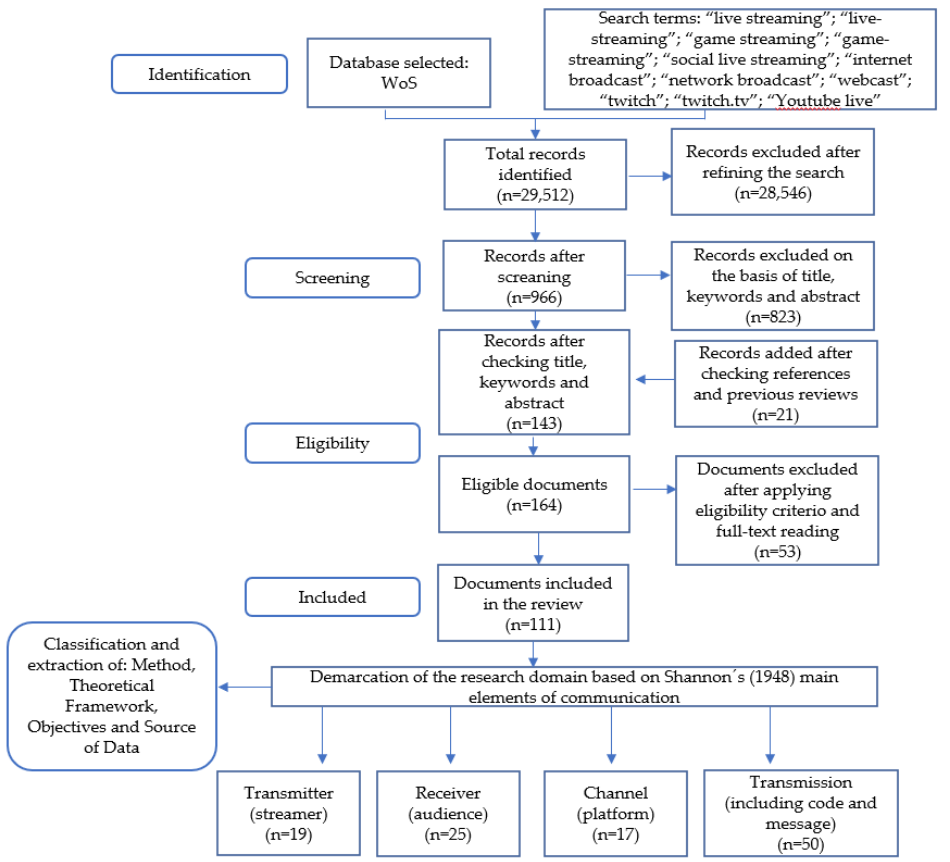
Figure 1. Flow diagram adapted from the Preferred Reporting Items for Systematic Reviews and Meta-Analysis (PRISMA) protocol.